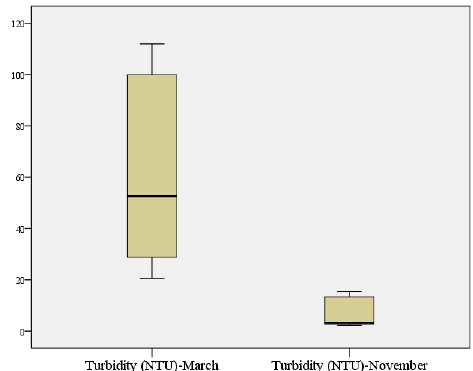
Figure 4. Box plots showing the spatial variability in turbidity on 13 March and 27 November 2014.